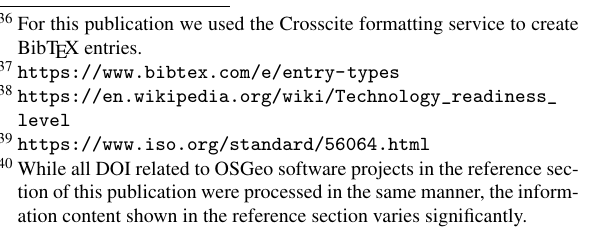
Figure 4. The Techological Readiness Level Scale (Source: Wikipedia © NASA/Airspace Systems (AS), public